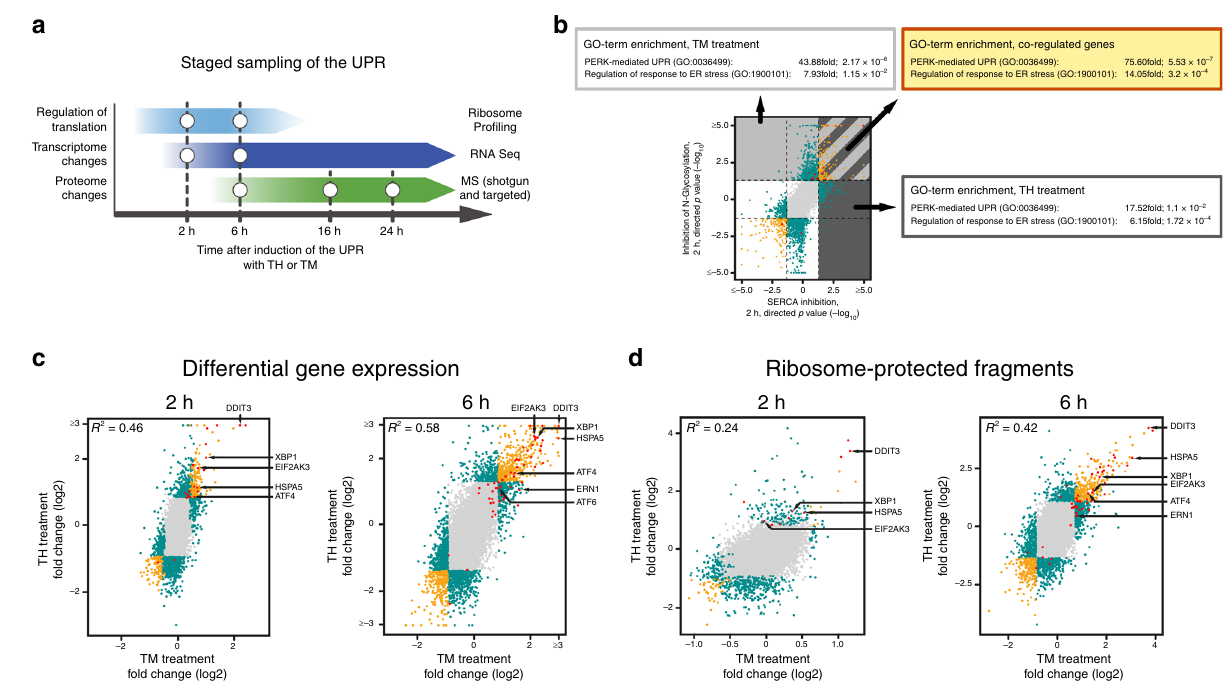
Fig. 1 A multi-omics approach to analyze the UPR. a Schematic depiction of the staged sampling scheme employed in this study. b Comparison of TM- and TH-induced changes to RNA expression levels highly enriches for factors involved in the UPR. Plotted are directional P -values of differentially expressed protein-coding genes after 2 h of treatment. Enrichment scores and P -values for the GO-terms PERK-mediated UPR (GO:0036499) and regulation of response to ER stress (GO:1900101) are given for genes that are upregulated after (1) inhibition of N-glycosylation (by TM treatment, area shaded in light gray) (2) after inhibition of the SERCA (by TH treatment, area shaded in dark gray) and (3) upregulated in both treatments (striated area). c Comparison of differences in mRNA abundance of protein-coding genes induced by treatment with TM or TH for 2 h (left panel) and 6 h (right panel) (see also Supplementary Fig. 2 and Supplementary Data 2). d Comparison of TM- and TH-induced changes to ribosome-protected fragment counts after 2 h (left panel) and 6 h of treatment (right panel) (see also Supplementary Fig. 4 and Supplementary Data 3). In c , d log2-fold changes of mean values are plotted. Two criteria were used to identify regulated genes: (a) fold-change in the 5% (downregulation) and 95% (upregulation) quantiles and (b) a P - value threshold (<0.05). Color coding b – d — gray dots: no signi fi cant change in either treatment; green dots: signi fi cantly upregulated or downregulated in only one treatment or inversely regulated upon TM and TH treatment; yellow dots: statistically signi fi cant regulation in the same direction in both treatments; red dots: known factors of the UPR. Select factors involved in the UPR are marked by